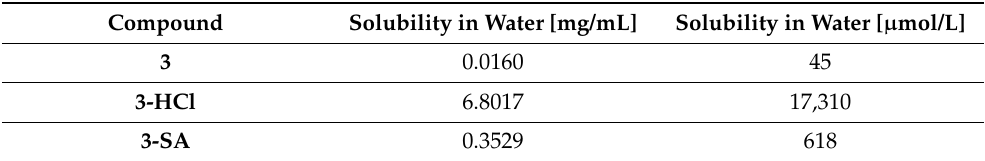
Table 6. Water solubility of tested